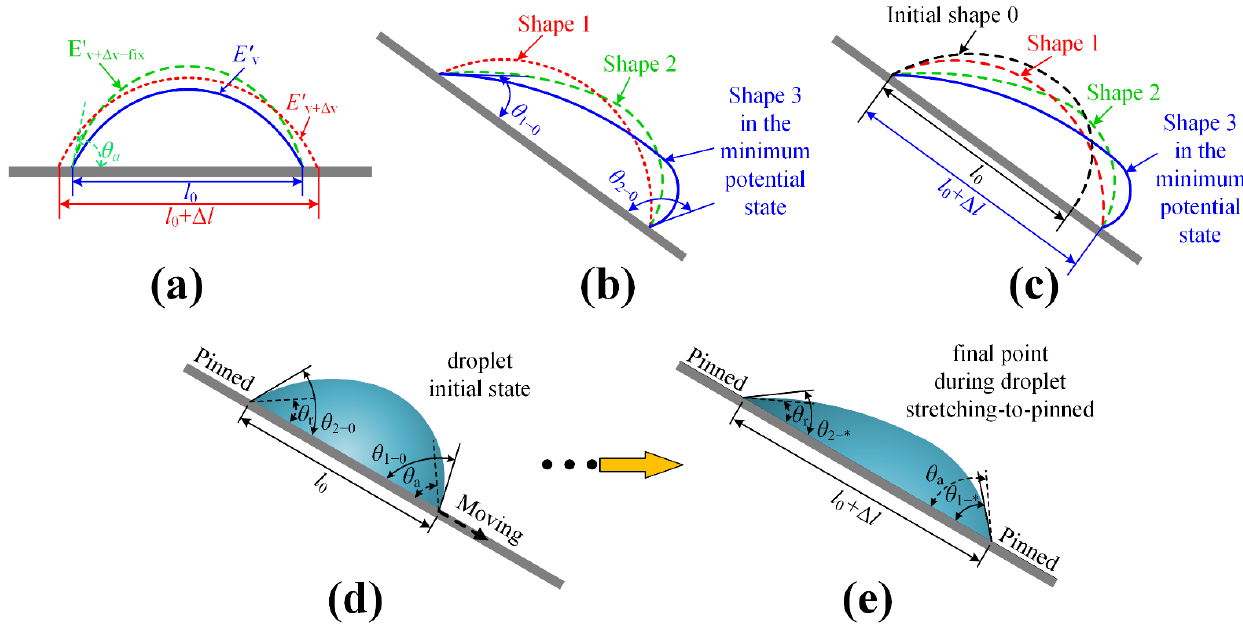
Figure 1. A simple description for methods of Models 1–3 and the predictions. ( a ) Model 1 description: when the droplet volume increases from V to V + ∆ V , but the contact line is fixed, the droplet has the potential energy ∆ E = 𝐸 v+ Δ v - fix ′ ∆ v − fix E v + (cid:48)